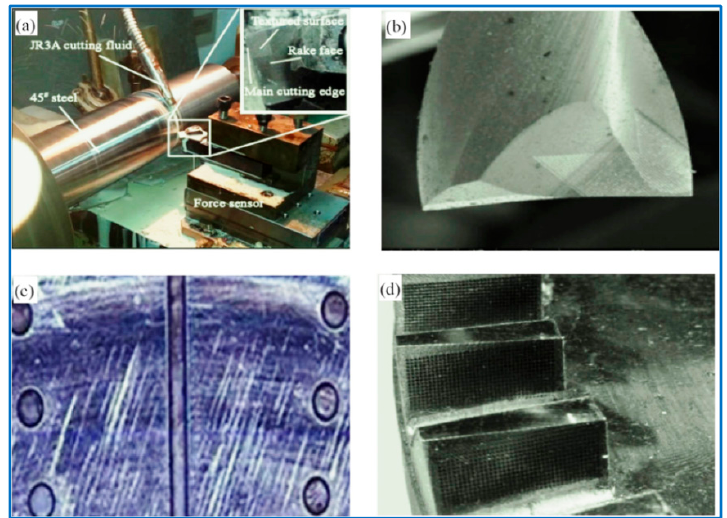
Figure 1. CIMT representations ( a , b ) A tool surface, ( c ) Cylinder inner liner surface, ( d ) MGP